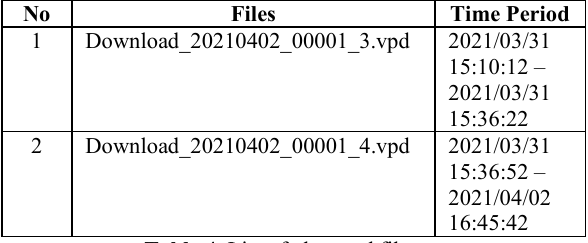
Table 4. List of observed files